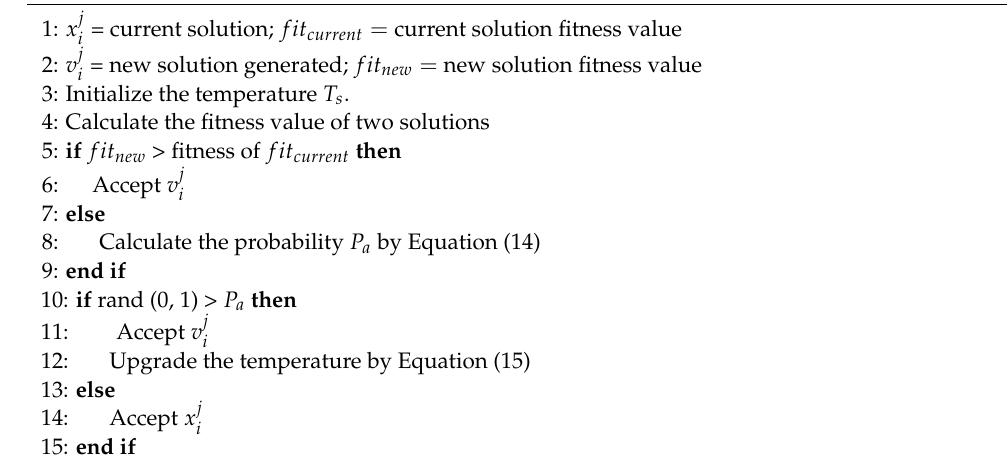
Algorithm 1 The Simulated Annealing Search Process in the CASAWOA